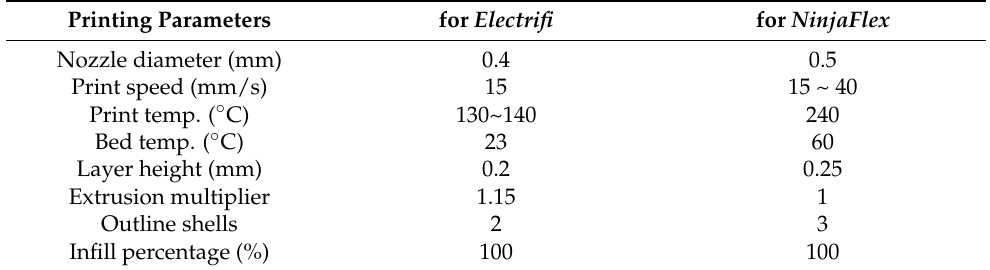
Table 1. Printer settings for conductive Electrifi and nonconductive NinjaFlex filaments. Printing